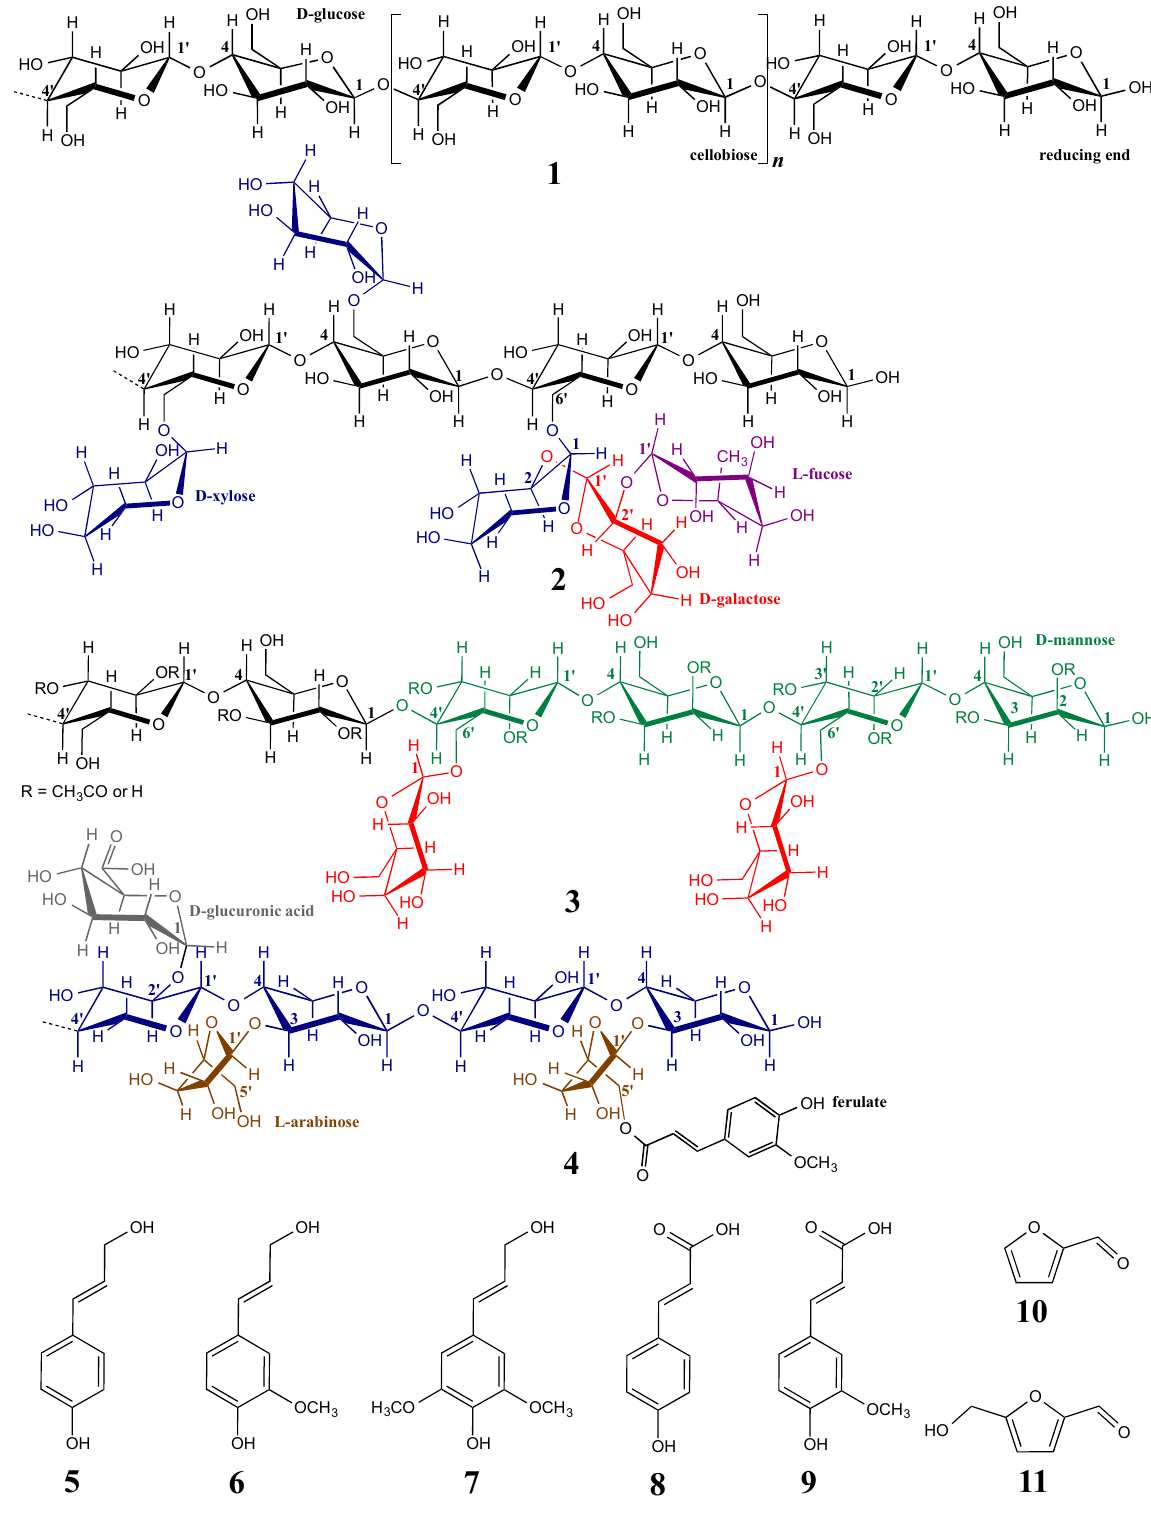
Figure 1. Structures of the cell wall polymers cellulose ( 1 ), (fucogalacto)xyloglucan ( 2 ), galactoglucomannan ( 3 ), glucuronoarabinoxylan ( 4 ). Sugar residues are color coded. Also shown are the phenolic compounds p -coumaryl alcohol ( 5 ), coniferyl alcohol ( 6 ), sinapyl alcohol ( 7 ), p -coumaric acid ( 8 ), and ferulic acid ( 9 ) and the breakdown products furfural ( 10 ) and hydroxymethylfurfural ( 11 ) derived from pentose and hexose sugars,